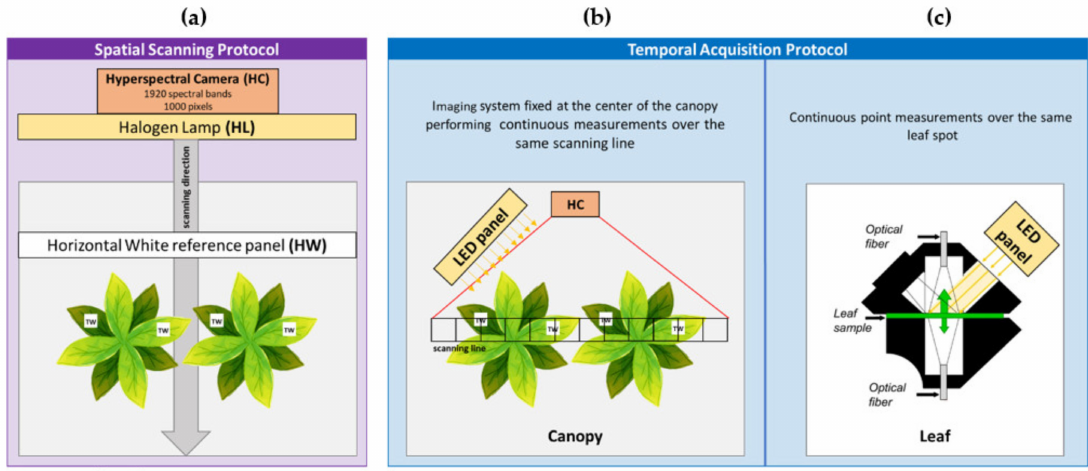
Figure 2. Details of the canopy and leaf spectral measurement protocols carried out with the hy- perspectral HySpec VNIR imaging systems and the point spectroradiometer. ( a ) Canopy imaging system with the target white (TW) references placed on top of the leaves and the horizontal white reference (HW) panel at the beginning of the scanning trajectory. ( b ) Imaging temporal acquisition protocol, where the grid lines represent a measurement for each sample line under a sudden exposure of strong light produced by the LED panel (2000 µ mol m − 2 s − 1 ). In this protocol, the halogen lamp was switched off. ( c ) Point temporal acquisition protocol at the leaf level, measurement by a spectroradiometer optical fiber inserted in the top port (nadir looking) of the FluoWat leaf clip (the leaf clip figure was adapted from